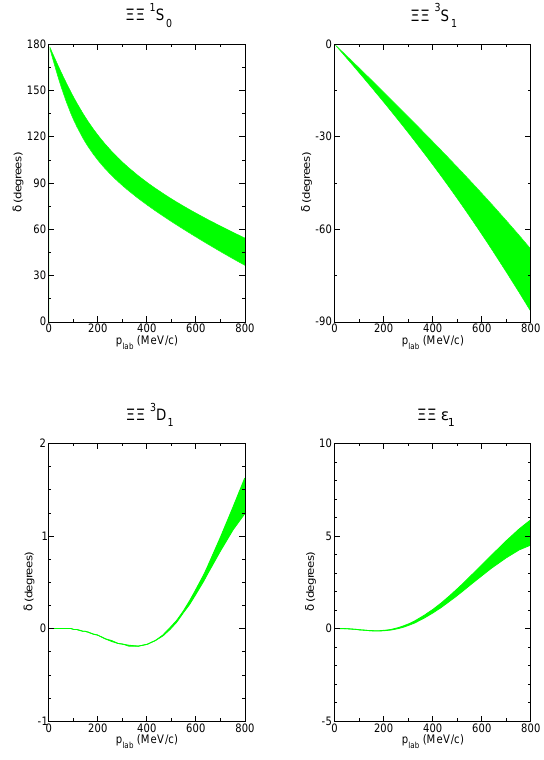
Fig. 8. Selected phase shifts for ΞΞ . The shaded band shows the chiral EFT results to LO for variations of the cut-o ff in the range Λ = 550 . .. 700